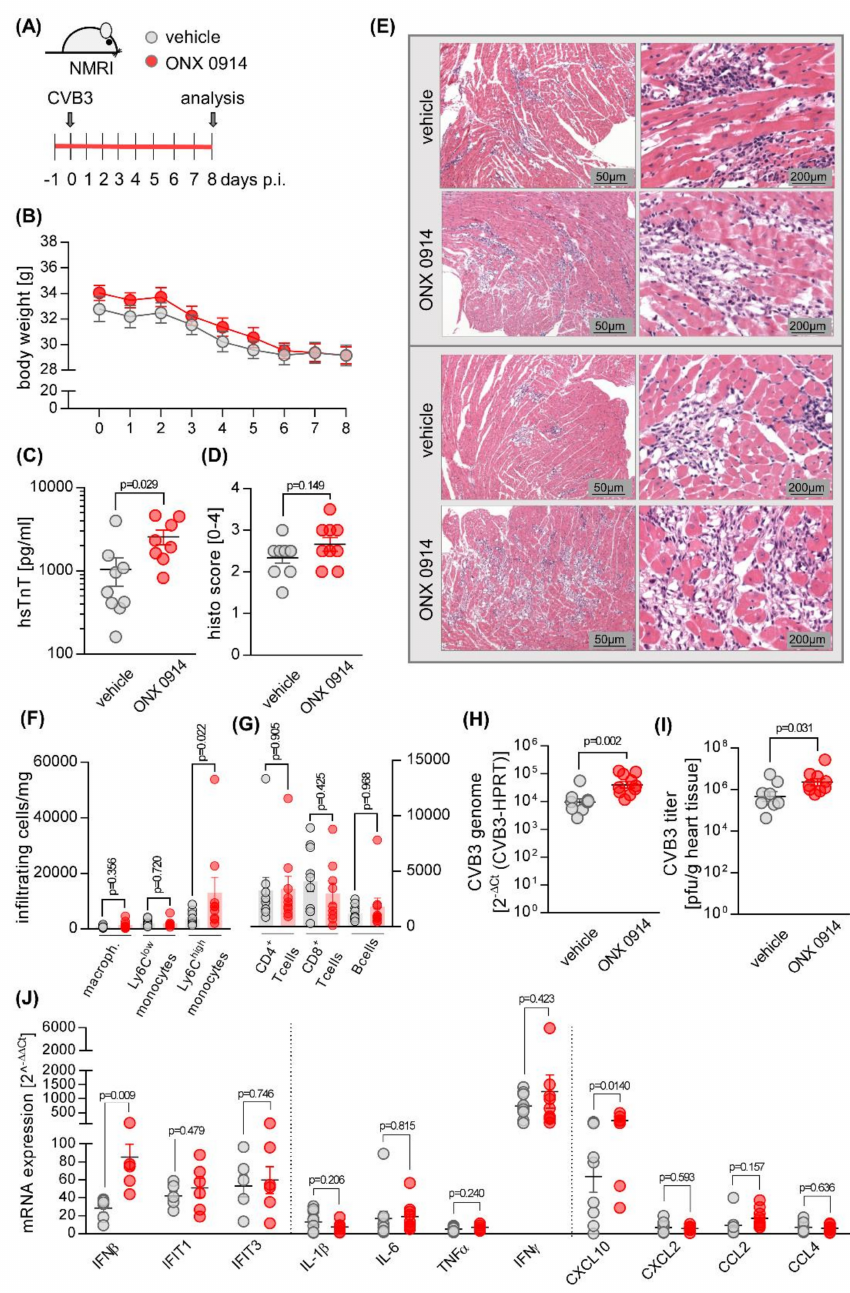
Figure 3. ONX 0914 treatment prior to infection with CVB3 exacerbates virus-mediated heart tissue injury. ( A ) Mice received either ONX 0914 (10 mg / kg bodyweight) or vehicle daily until day 8, starting one day prior to infection with 5 × 10 5 pfu of CVB3 strain 31-1-93. ( B ) Body weight was monitored daily and analyzed using two-way ANOVA. ( C ) On day 8, blood was drawn for measurement of hsTnT. ( D ) Mice were sacrificed on day 8. For histological analysis, HE-stained heart tissue sections were scored microscopically for myocardial cell death and inflammation. ( E ) Images from two representative mice per treatment group are shown. ( F , G ) Single cell solutions from heart tissue were generated and analyzed by flow cytometry for infiltration of immune cells. The viral load in infected mouse hearts was determined by quantification of the CVB3 genome, applying qPCR ( H ) and by quantification of viral titers, using plaque assay ( I ). Heart tissue was homogenized and RNA was extracted for qPCR-analysis of the indicated genes ( J ). Relative mRNA levels were normalized to the housekeeping gene HPRT and mRNA induction was normalized to data obtained with non-infected mice. Data are mean ± SEM, p -values are indicated in each graph. If not indicated otherwise, data was analyzed using unpaired t